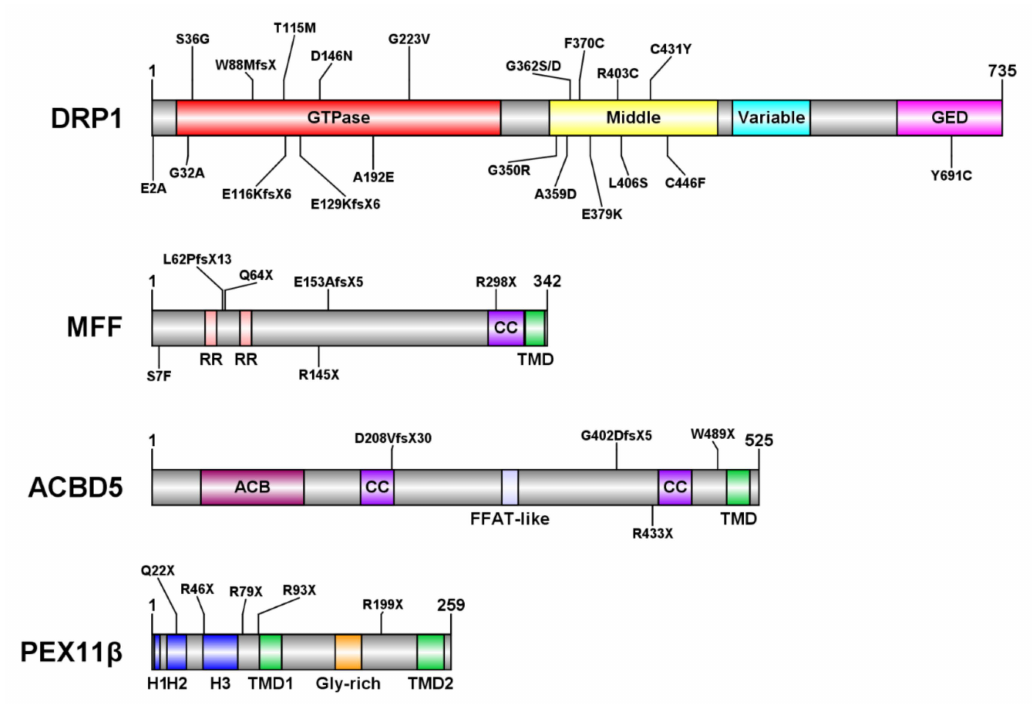
Figure 2. Domain structure of human DRP1, MFF, ACBD5, PEX11 β and known pathogenic